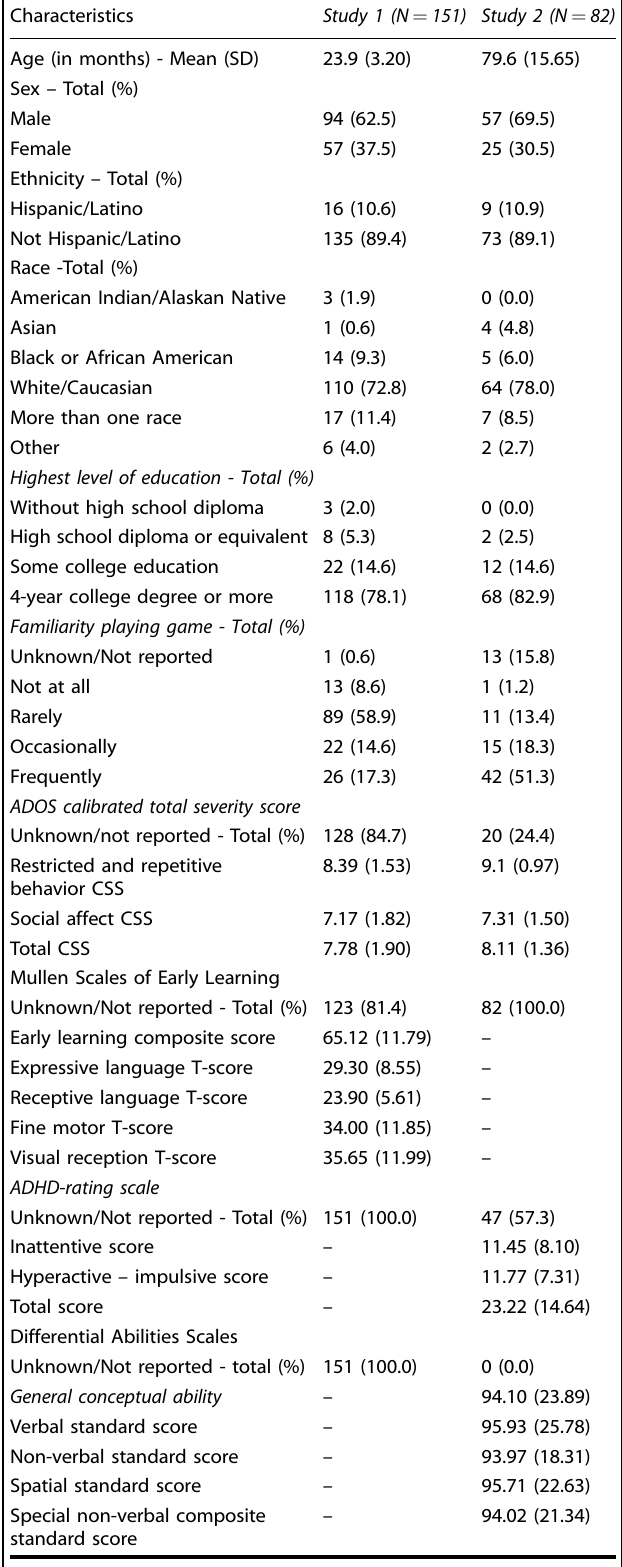
Table 1. Demographic characteristics of study